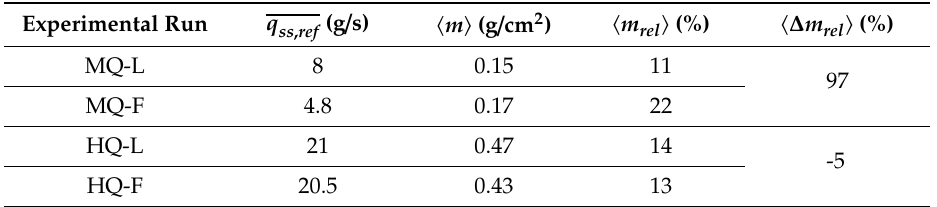
Table 3. Total net deposition for the four experimental runs, showing the reference time-averaged suspended sediment (SS) fluxes q ss , ref , spatially-averaged net deposition per unit area (cid:104) m (cid:105) , the relative net deposition as the share of the total SS flux (cid:104) m rel (cid:105) , and the relative change in deposition in the foliated compared to the leafless condition (cid:104) ∆ m rel (cid:105) . MQ = medium flow rate (50 L / s); HQ = high flow rate (83 L / s); L = leafless; F = foliated. Experimental Run q ss , ref (g / s) (cid:104) m (cid:105) (g / cm 2 ) (cid:104) m rel (cid:105) (%) (cid:104) ∆ m rel (cid:105)